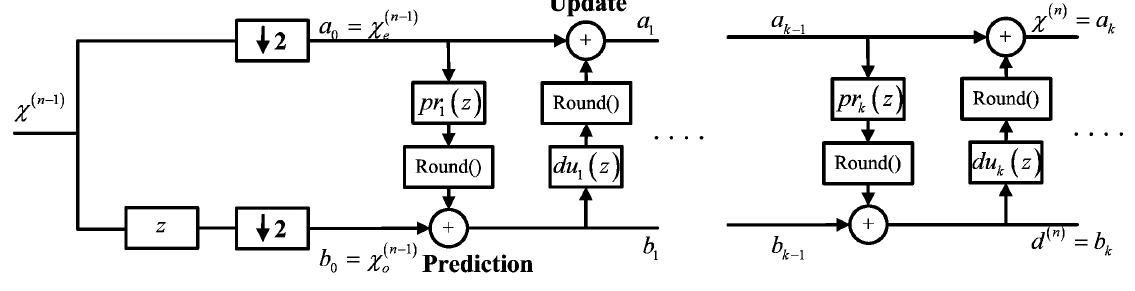
Figure 3. The structure of lifting scheme in